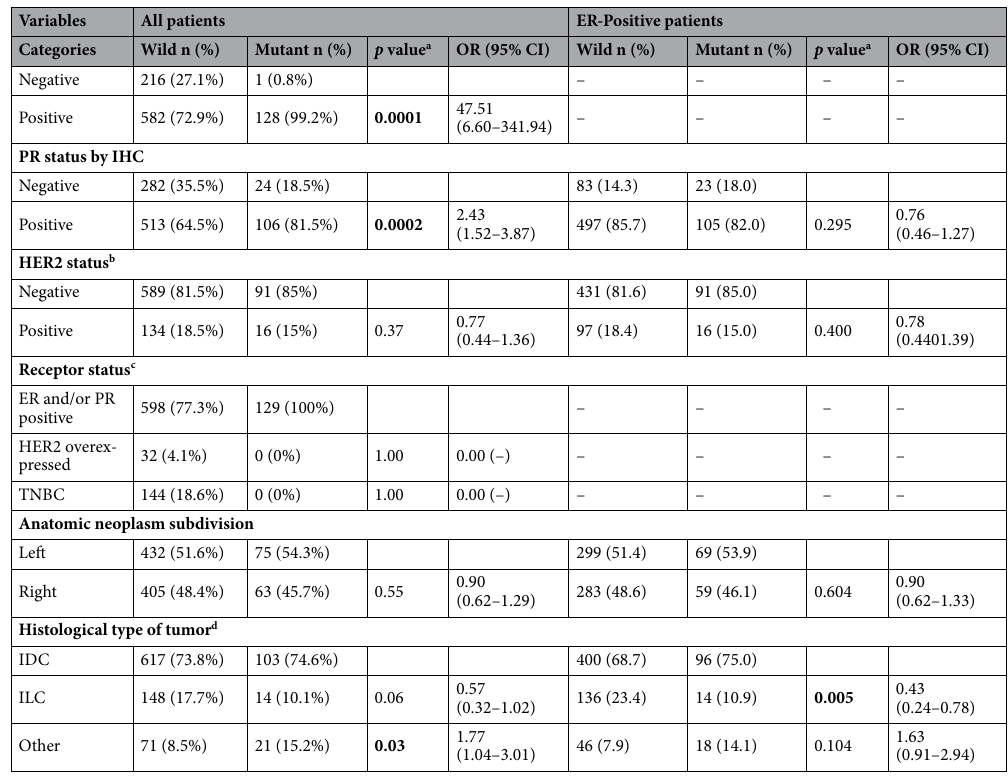
Table 1. Results of univariate logistic regression analysis examining the association between GATA3 mutation status and clinical features. AJCC American Joint Committee on Cancer, CI confidence interval, ER estrogen receptor, IDC invasive ductal carcinoma, IHC immunohistochemistry, ILC invasive lobular carcinoma, ISH in situ hybridization, OR odds ratio, PR progesterone receptor, TNBC triple negative breast cancer. a Significant p values are shown in bold. b According to ISH/IHC results. c Association between the receptor status and GATA3 mutation status cannot be estimated because all GATA3 mutant tumors are also ER and/or PR positive. Significant p values are shown in bold. d Other category includes rare types of tumors (e.g. Metaplastic, Medullary tumors).